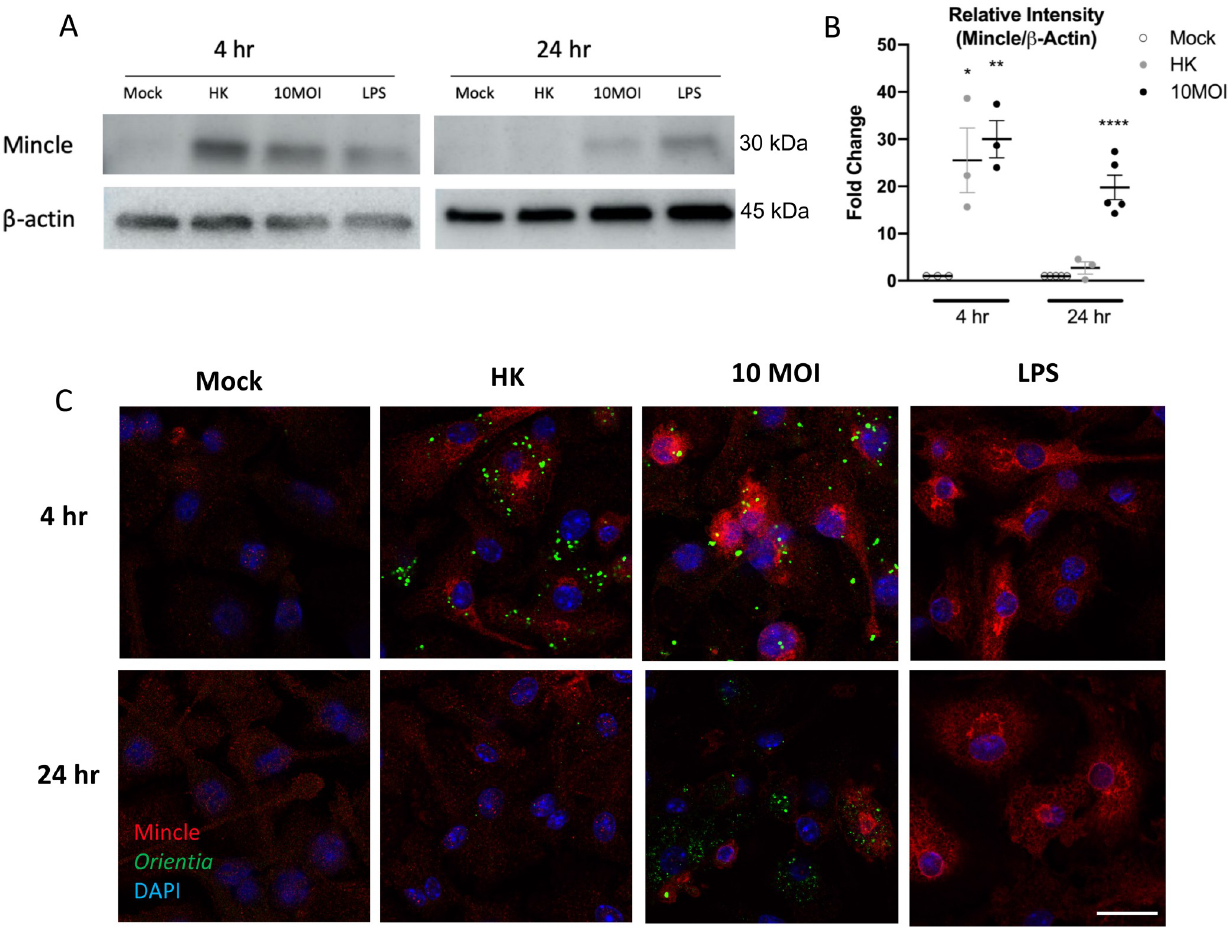
Fig 7. Mincle levels and distribution in M F exposed to live and inactivated bacteria. Bone marrow-derived M F of C57BL/6J mice were exposed to live bacteria (MOI 10), heat-killed bacteria (HK, MOI 10 equivalent), or LPS (100 ng/ml, as a positive control for Mincle expression). (A) Western blots (5 μ g protein/lane) of cell lysates for the levels of Mincle and β -actin at 4 and 24 hr. (B) Densitometry of bacterium-exposed groups with a minimum of 3 representative blots by using ImageJ. Fold changes were determined relative to Mincle proteins in control samples and shown as mean ± SEM. (C) Immunofluorescent assay detection of Mincle (red), O . tsutsugamushi (green), and DNA (DAPI, blue) in cells at 4 and 24 hr of incubation (scale bar = 20 μ m). One-way ANOVA with Dunnett’s multiple comparison test was used for statistical analysis, with mock samples as the references. � , p < 0.05; �� , p < 0.01; ���� , p <